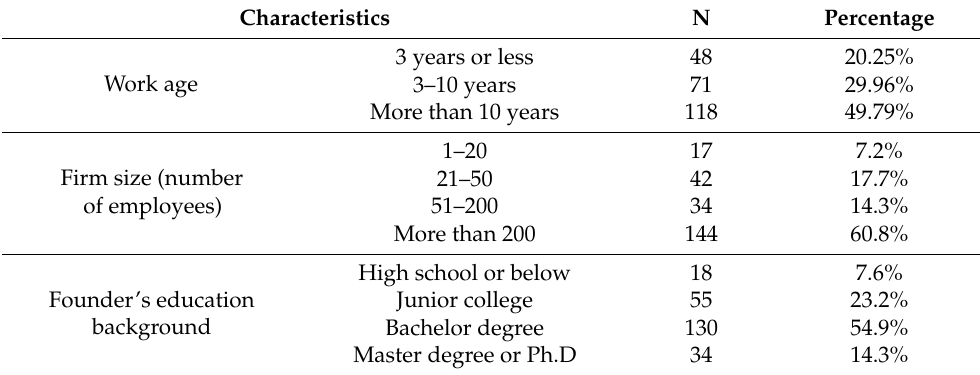
Table 1. The profiles of the